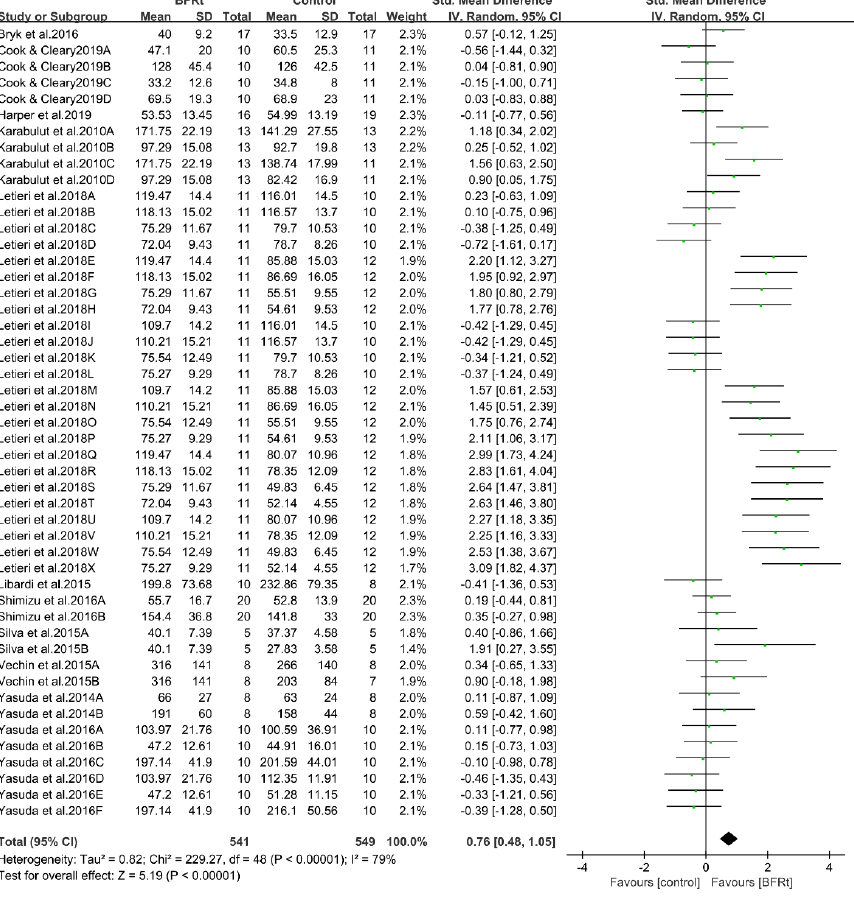
Figure 4. Pooled outcomes of the effect of BFRt intervention on lower-limb muscle strength. Different letters for the same study represent different muscle strength assessment methods [19,22,29–37].